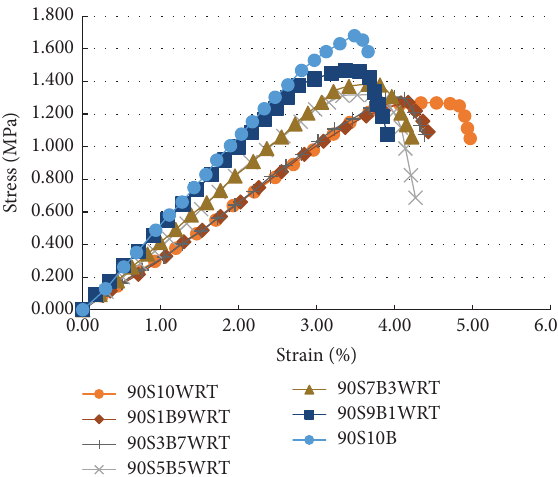
Figure 6: Stress-strain diagram of 28days cured